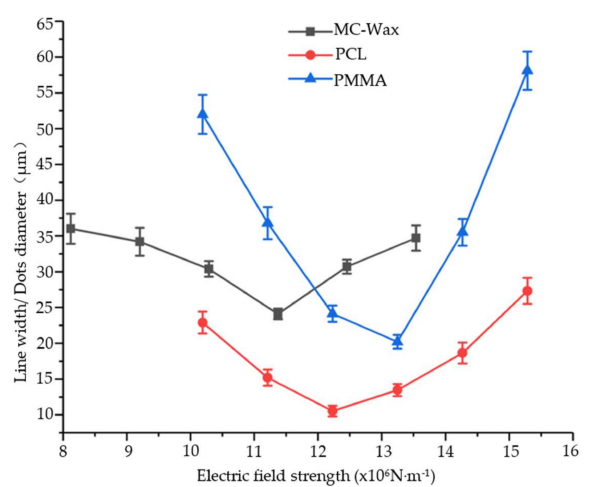
Figure 6. E ff ect of electric field strength on print line width and diameter.